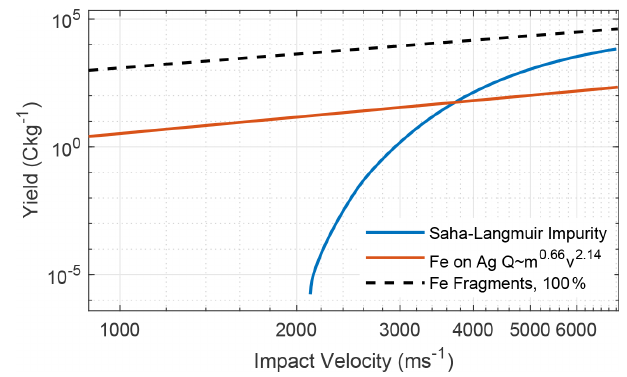
Figure 9. Comparison of specific yields from our contact charg- ing model (dashed) to the Saha–Langmuir solution from Drapatz and Michel (1974) (solid blue) and the semi-empirical law obtained by Mocker et al. (2013) (solid red). All lines represent Fe-on-Ag impacts, and in the Saha–Langmuir solution we have used potas- sium as the impurity. The label “100%” in the legend corresponds to χ = 1 and indicates that all produced fragments collide with the